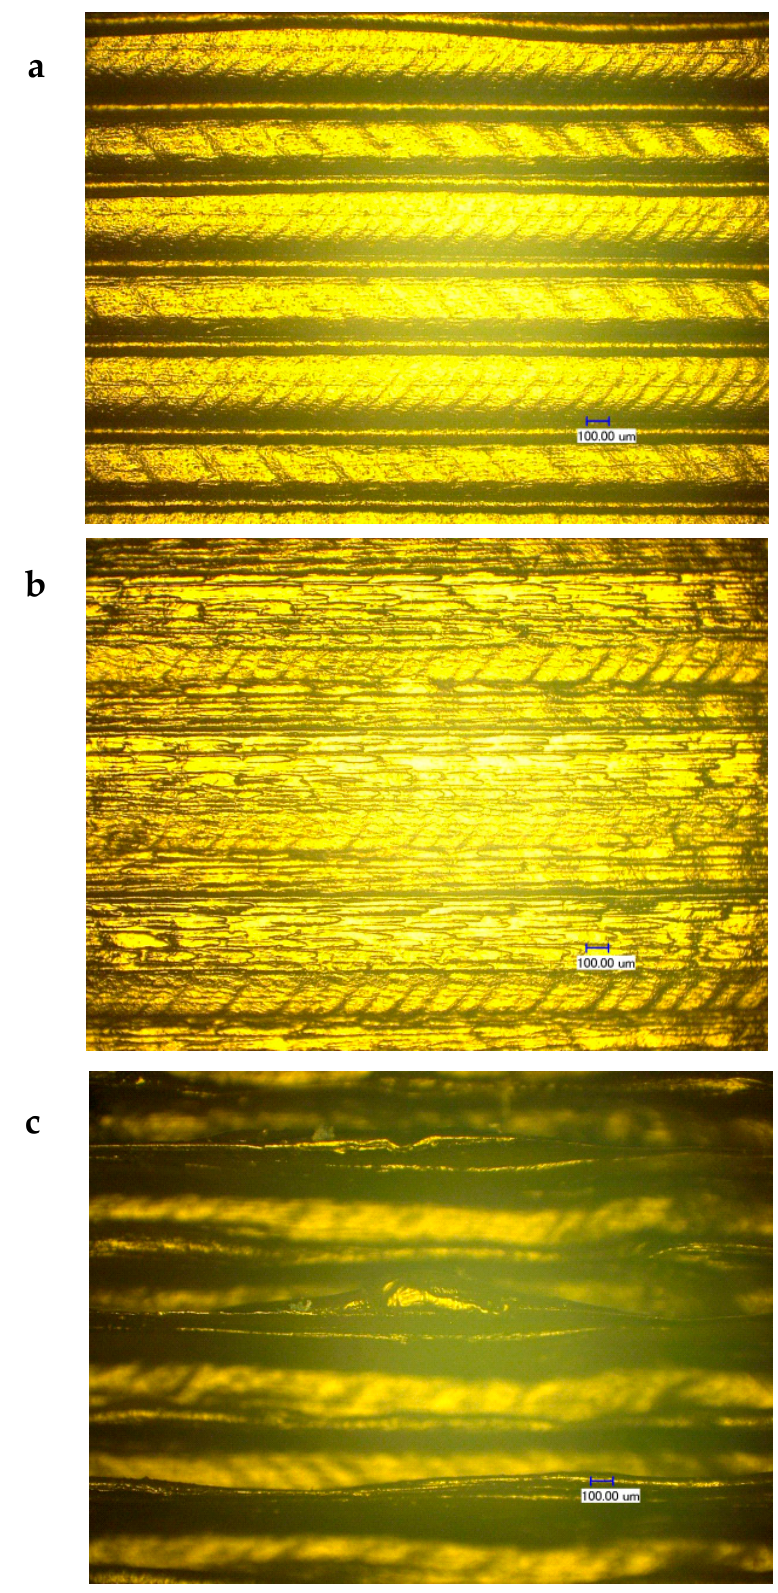
Figure 5. Light micrograph diagram of test piece surface. ( a ) Line-to-line overlapping ratio = 2%; ( b ) Line-to-line overlapping ratio = 15%; ( c ) Line-to-line overlapping ratio = 50%.